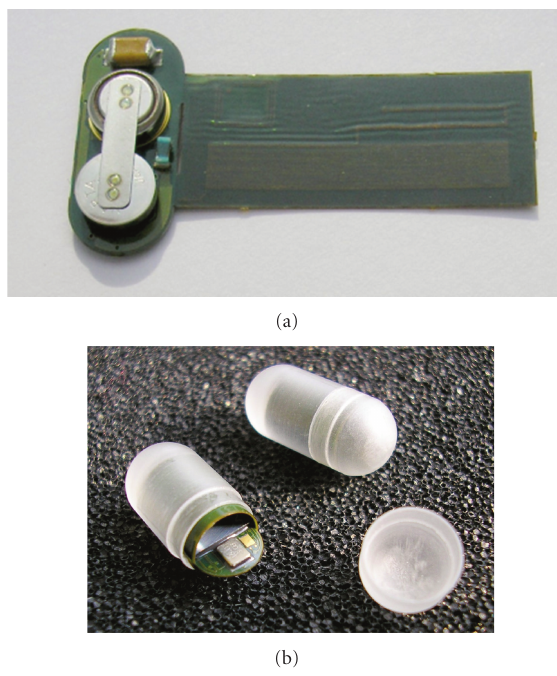
Figure 11: Structure of the